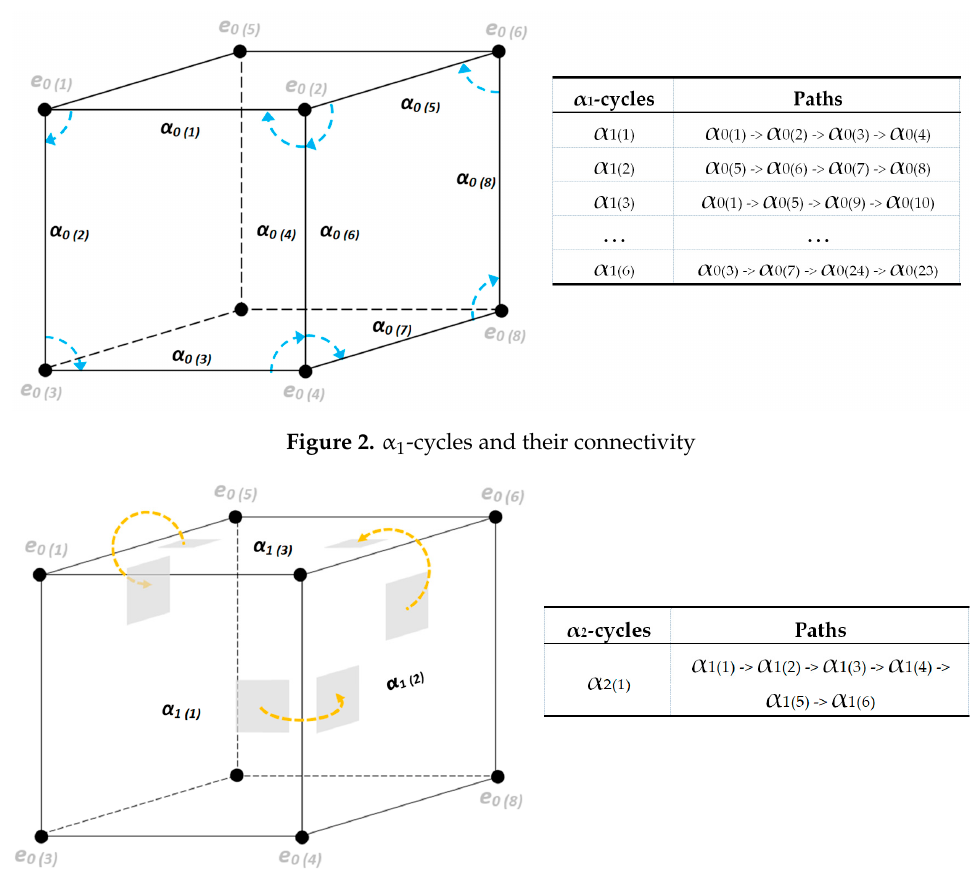
Figure 3. α 2 -cycles and their connectivity.